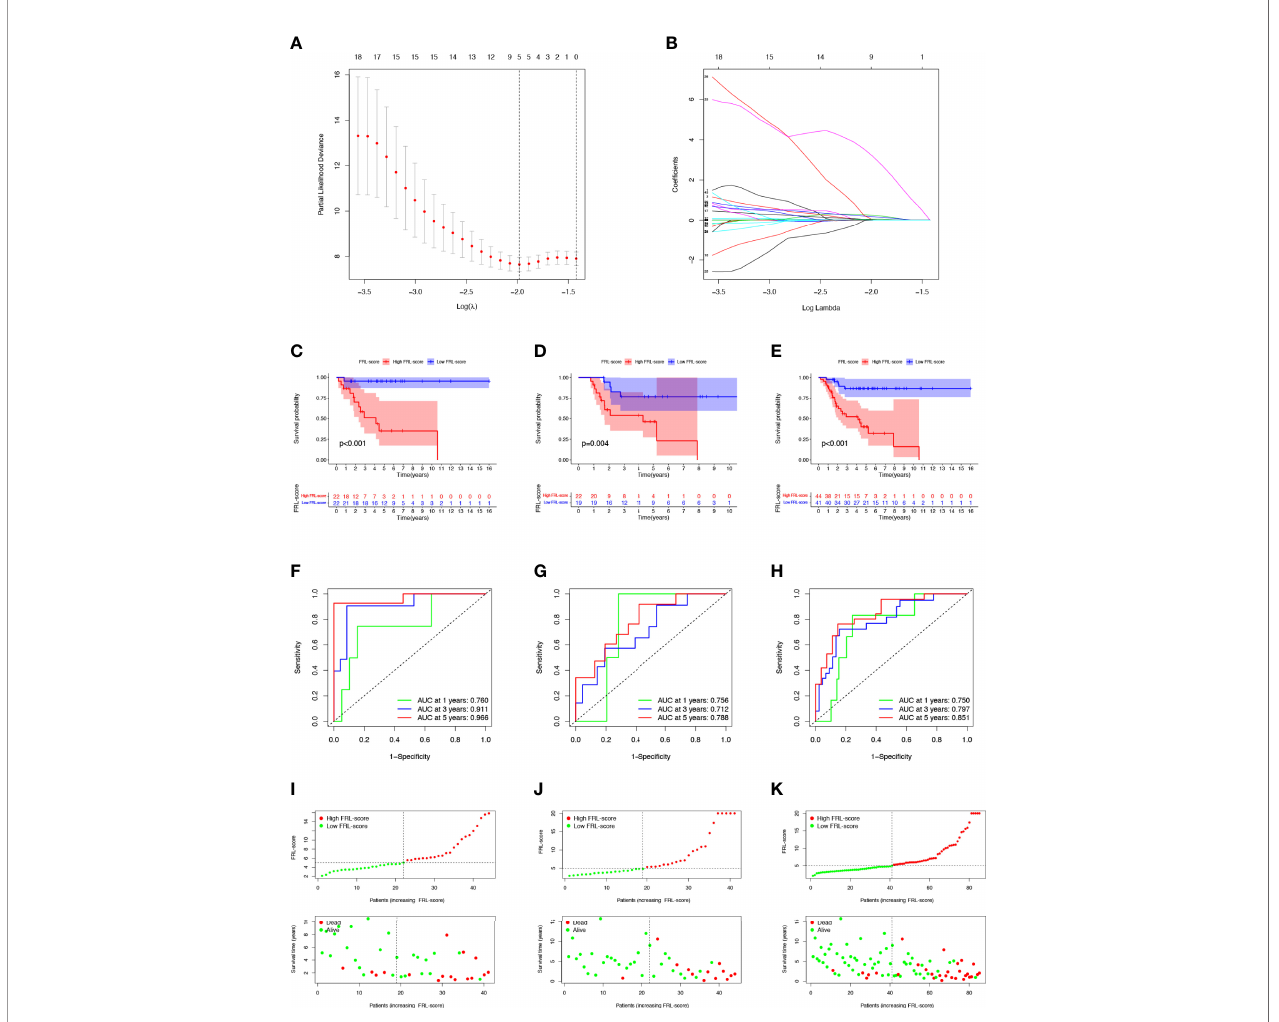
FIGURE 4 | Construction and evaluation of the FRL-based prognostic signature. (A, B) Construction of the FRL-based signature by LASSO regression analysis. (A) Obtainment of the optimal l value. (B) LASSO coef fi cient pro fi les of FRLs. (C – E) Survival analysis according to FRL-score in the training cohort (C) , validation cohort (D) , and whole cohort (E) . (F – H) ROC curve for forecasting overall survival in the training cohort (F) , validation cohort (G) , and whole cohort (H) . (I – K) The distribution of FRL- score, survival status, and survival time of patients in the training cohort (I) , validation cohort (J) , and whole cohort (K) . FRLs, ferroptosis-related